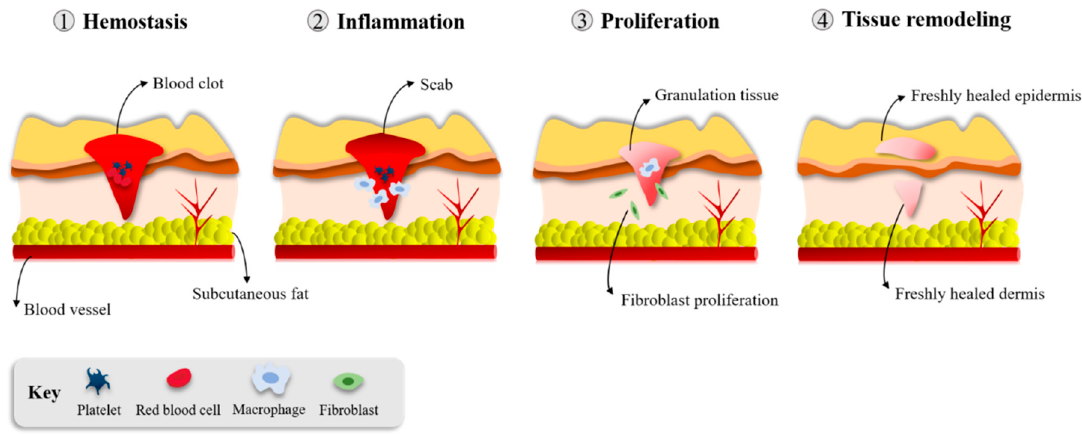
Figure 2. Phases of wound healing [4].